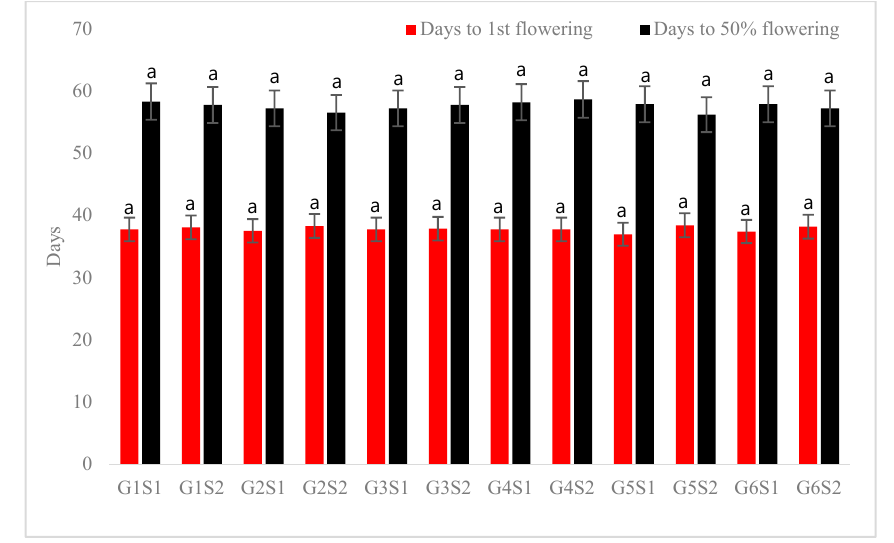
Figure 2. Effect of different graft combinations on initiation of tomato flowering of pomato plants. Figure 2. E ff ect of di ff erent graft combinations on initiation of tomato flowering of pomato plants. Mean values with different letters in a category are significantly different by Duncan’s Multiple Range Mean values with di ff erent letters in a category are significantly di ff erent by Duncan’s Multiple Range Test (DMRT) at P < 5% (n = 10). Test (DMRT) at P < 5% (n = 10).